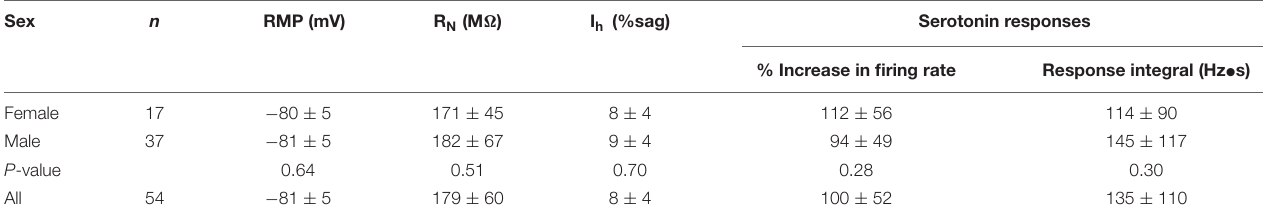
TABLE 1 | Physiology and serotonin responses in neurons from female and male mice. Sex RMP